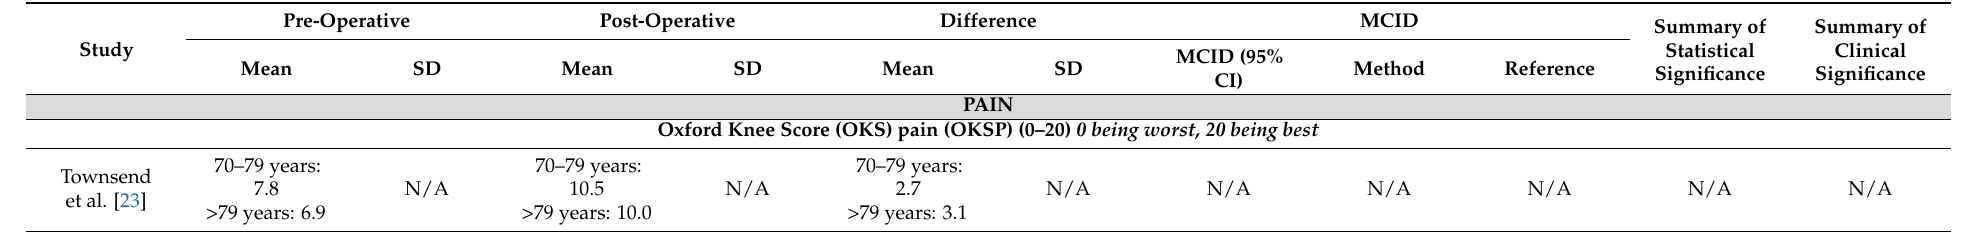
Table 3. Effect of total knee replacement on pain and functional